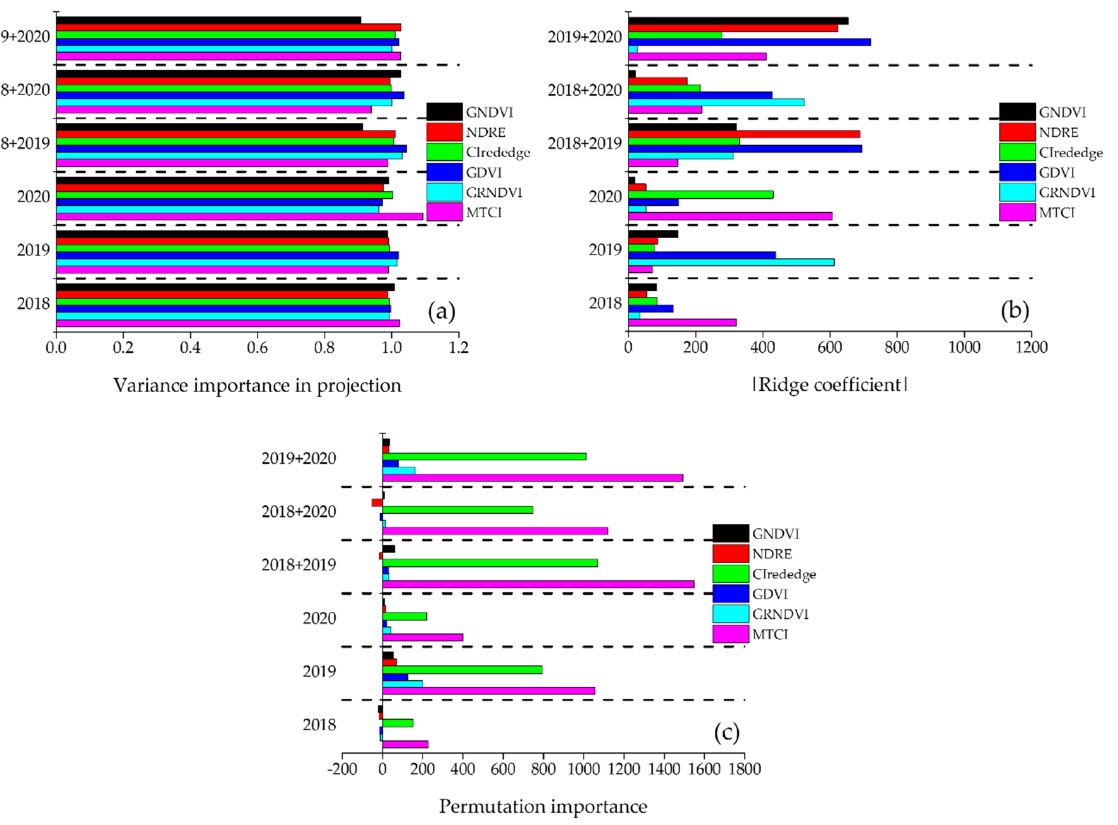
Figure 7. Importance of each vegetation index in ( a ) PLSR-, ( b ) RR-, and ( c ) ANN-based predictions of the rice yield.